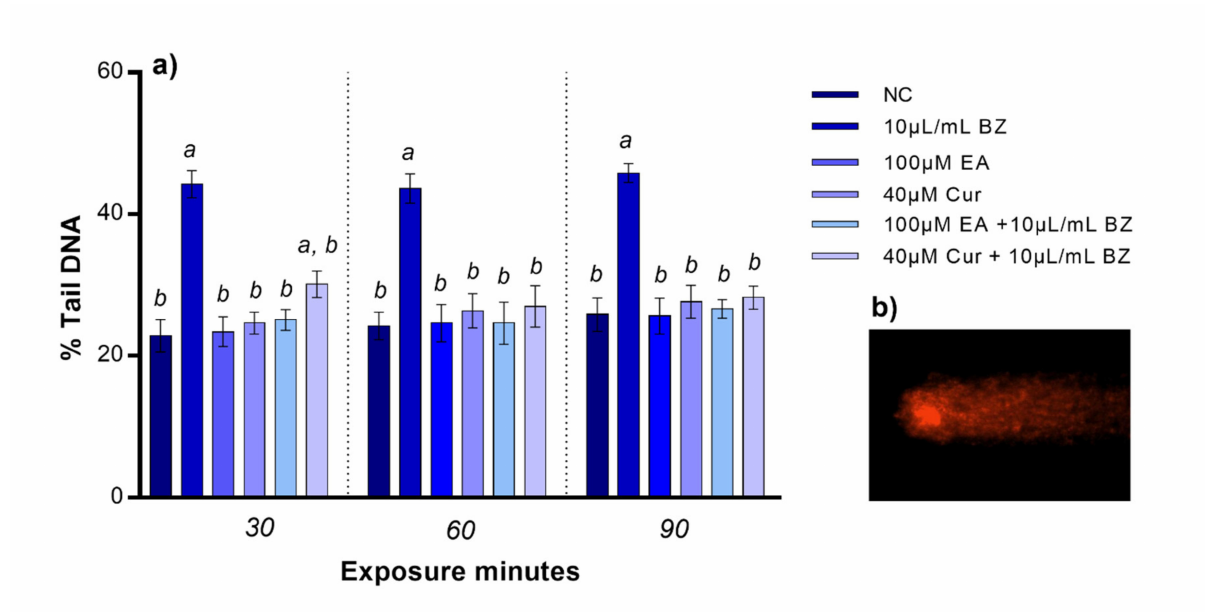
Figure 2. ( a ) Percentage of DNA in the comet tail (y-axis) in zebrafish blood cells at different exposure timepoints (x-axis). Benzene—BZ; Ellagic acid—EA; curcumin—Cur; negative controls—NC. Letters correspond to diverse statistical significances (ANOVA); a : p < 0.05 in comparison with NC; b : p < 0.05 in comparison with BZ exposure. ( b ) Comet tail DNA in zebrafish blood cell analyzed using Komet 5.5 software.